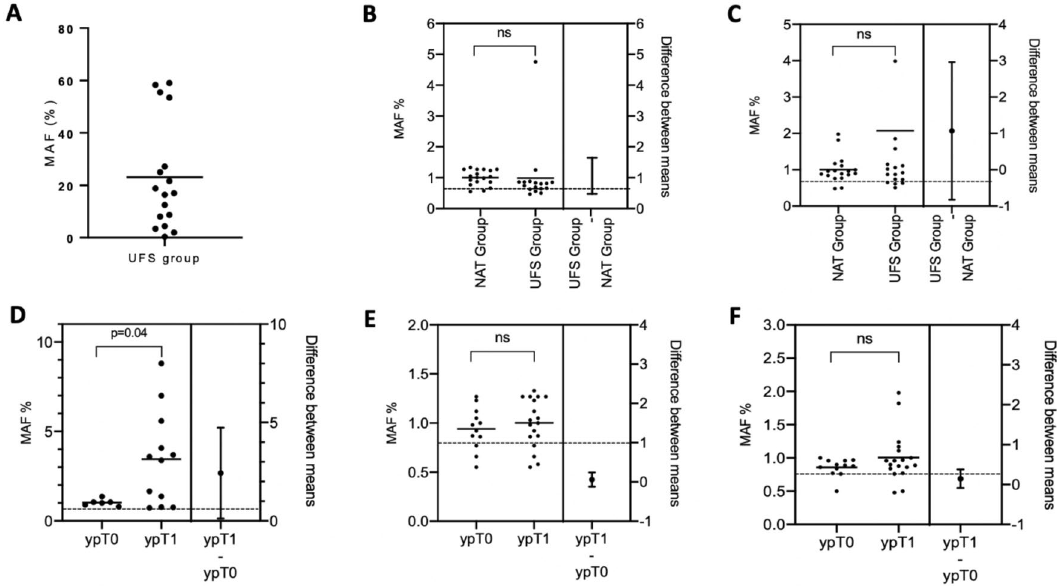
Figure 3. ( A ) Distribution of MAFs in tumour tissue from UFS group (line represents the average MAF value); Student t-test compared KRAS MAFs in sub-group of PDAC, ( B ) Resection margin between NAT and UFS group ( p = 0.95), ( C ) Venous margin between NAT and UFS group ( p = 0.26), ( D ) Tumour tissue between ypT0 and ypT1 tumour in the NAT Group ( p = 0.04); ( E ) Resection margin between ypT0 and ypT1 ( p = 0.30), ( F ) Venous margin between ypT0 and ypT1 ( p = 0.14). *MAFs: Mutation allelic frequencies; NAT: Neoadjuvant treatment; UFS: Up-front